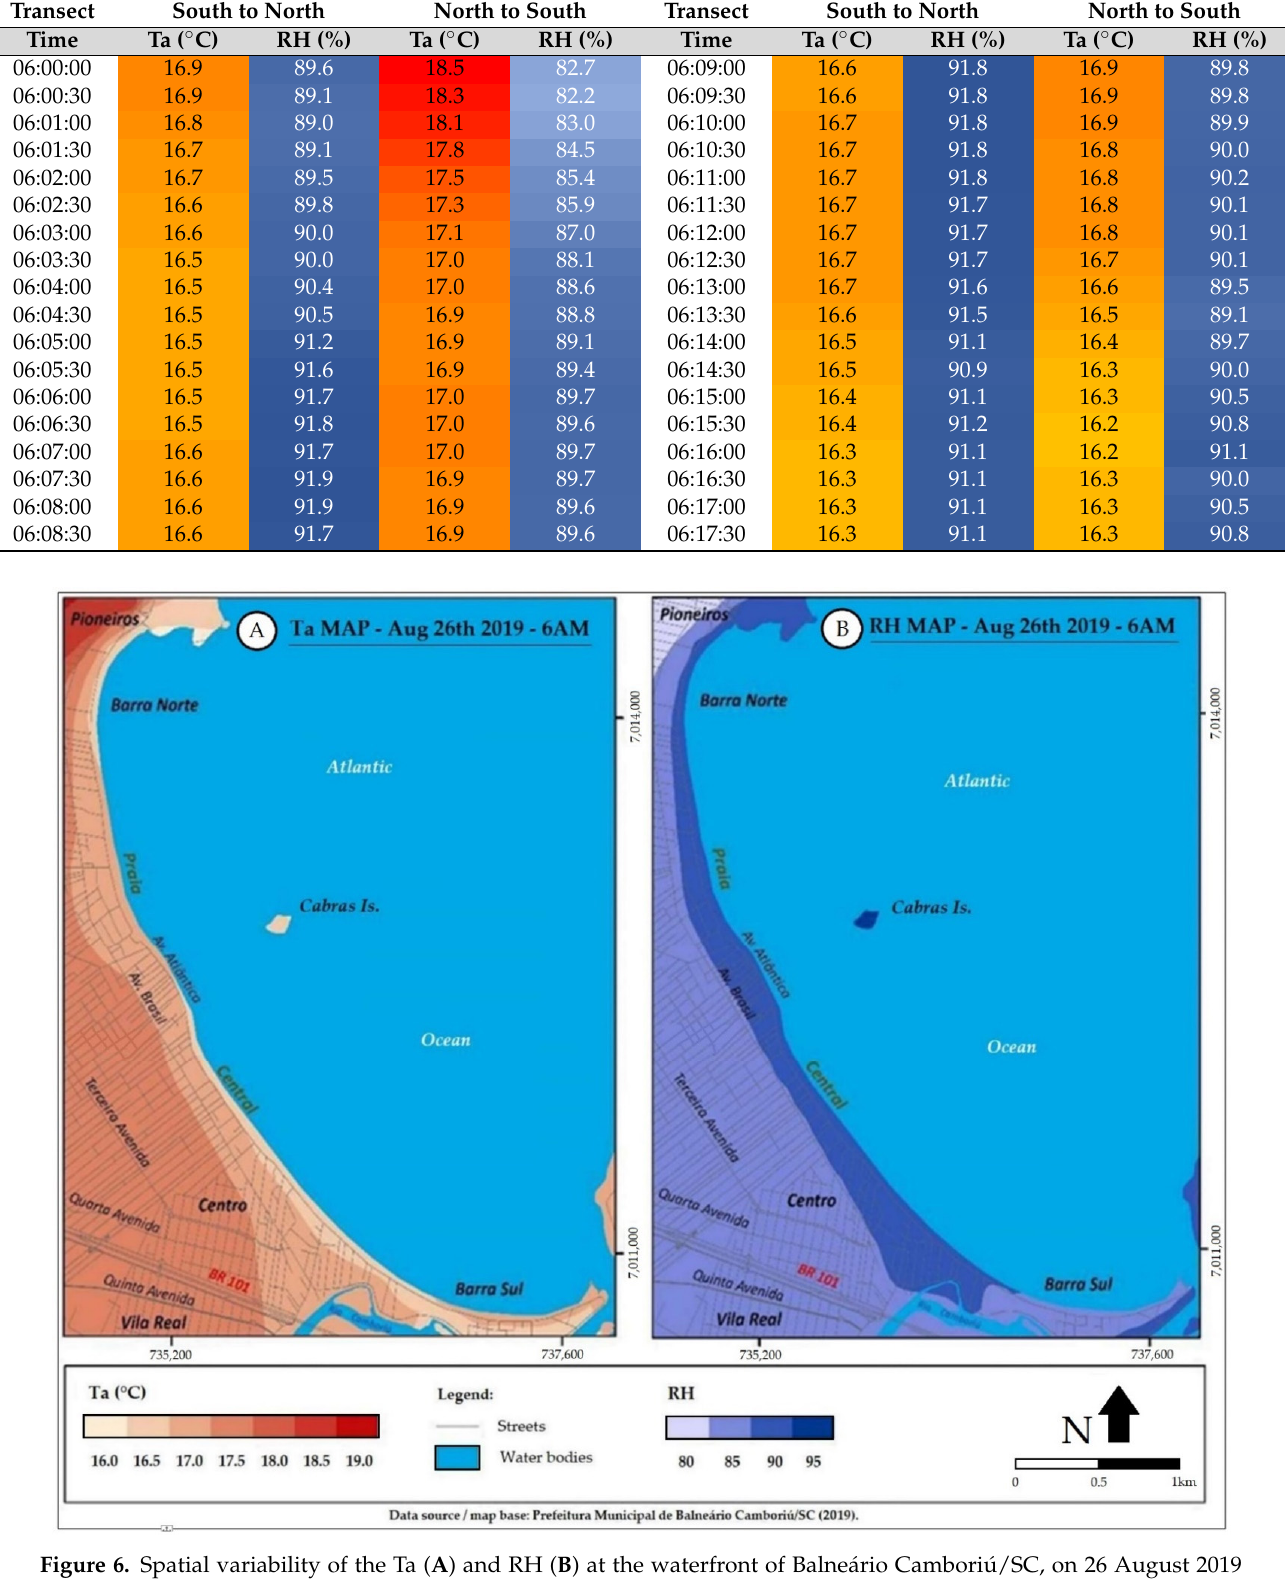
Table 2. Variations of Ta ( ◦ C) and RH (%) along the transects.